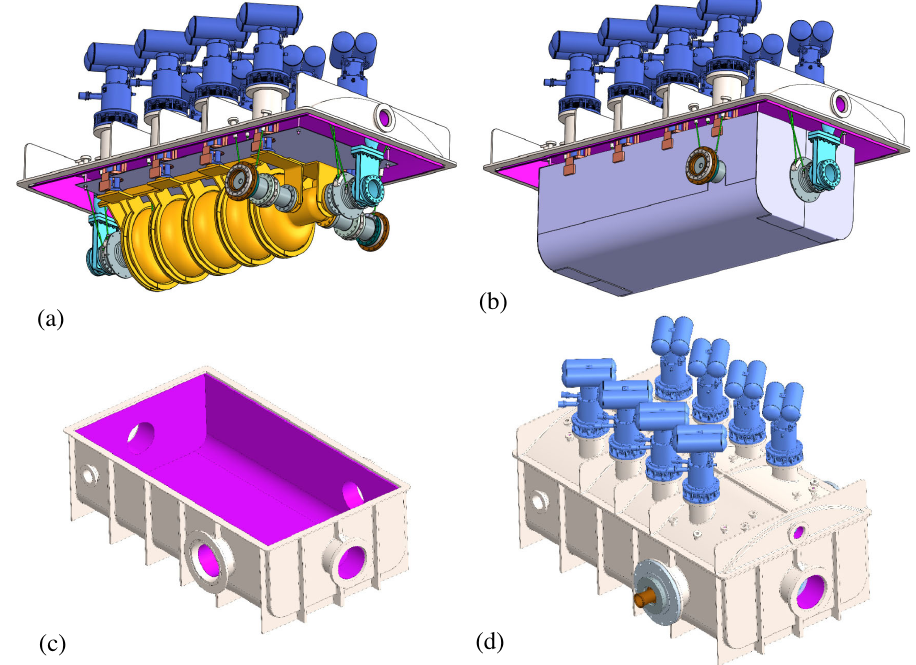
FIG. 26. Cryomodule assembly sequence. (a) Installation of the beam line assembly and cryocoolers on the vacuum vessel lid. (b) Installation of the thermal shield. (c) Installation of the bottom half of the magnetic shield inside the vacuum vessel tub and (d) fully assembled